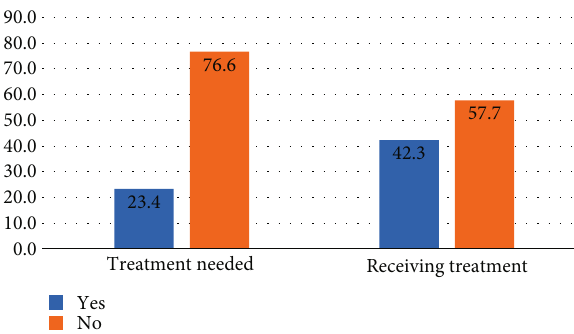
Figure 3: Proportion of patients (a) meeting treatment criteria and (b) able to initiate